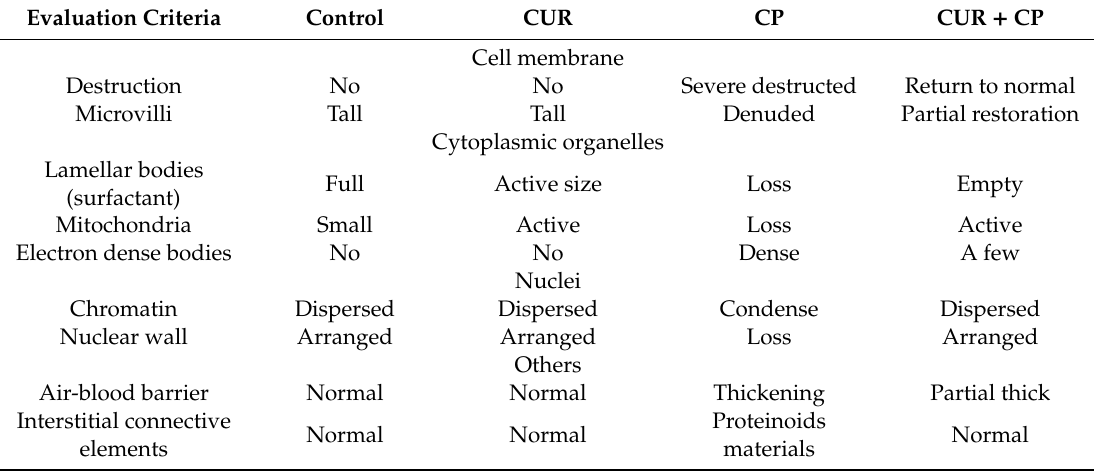
Table 2. Ultrastructure criteria evaluations of pneumocytes type II and blood–air barriers among different experimental groups.